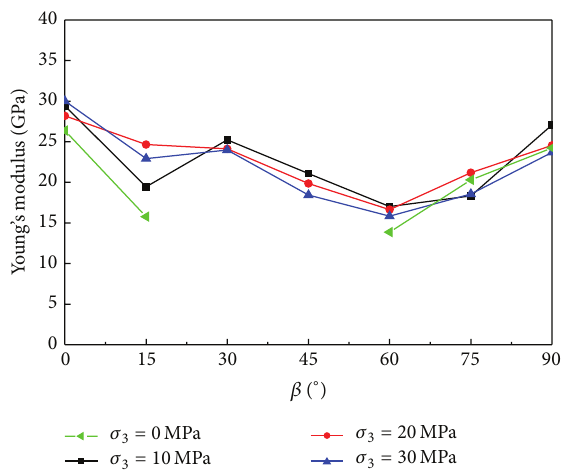
𝛽 at different confining pressures ( 𝜎 3 ).